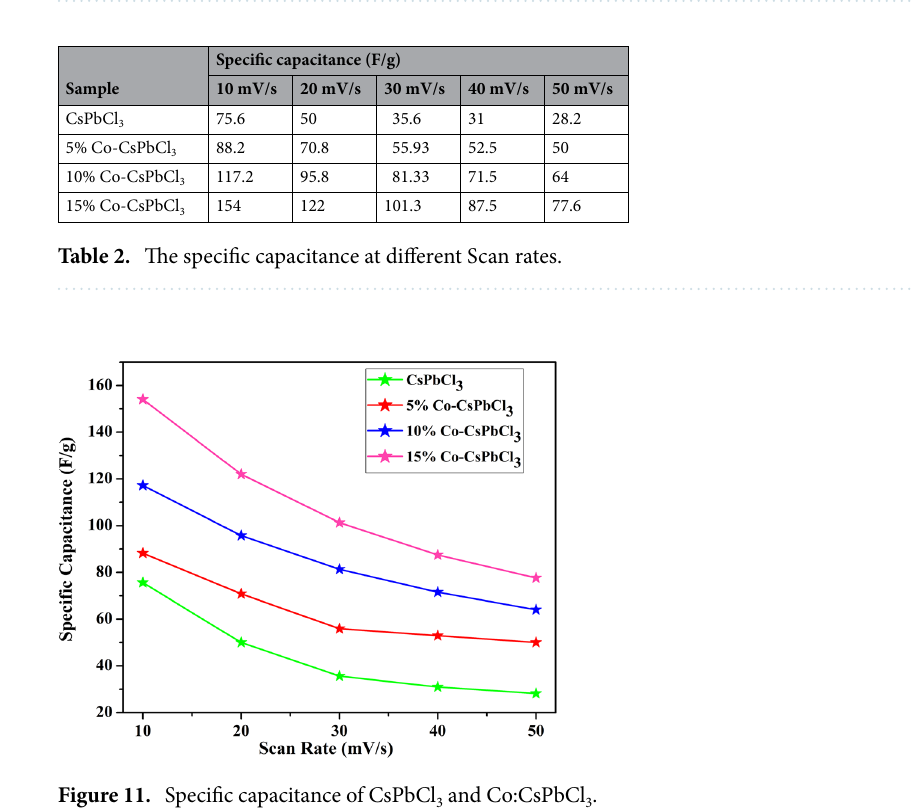
Figure 10. Represents the voltammogram of CsPbCl 3 and Co:CsPbCl 3 .